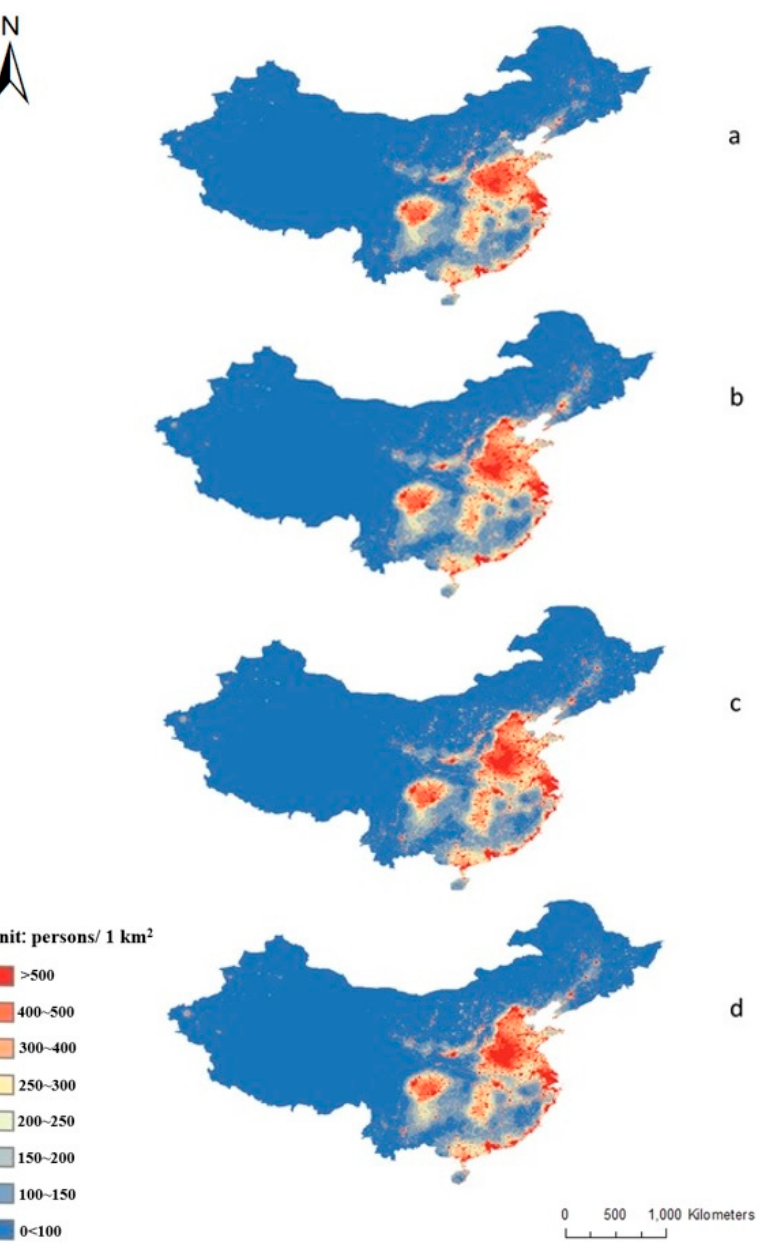
Figure 8. Estimated population density maps in ( a ) 2004, ( b ) 2007, ( c ) 2010, and ( d ) 2013 using ANNGWR.